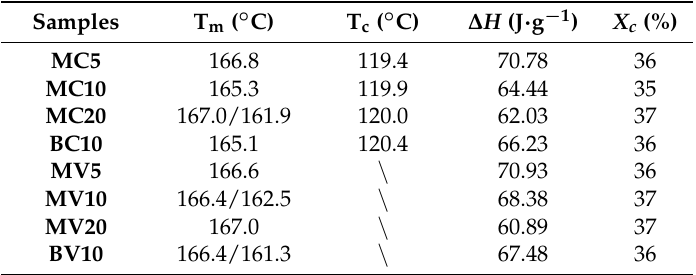
Table 3. Thermal properties during heating and